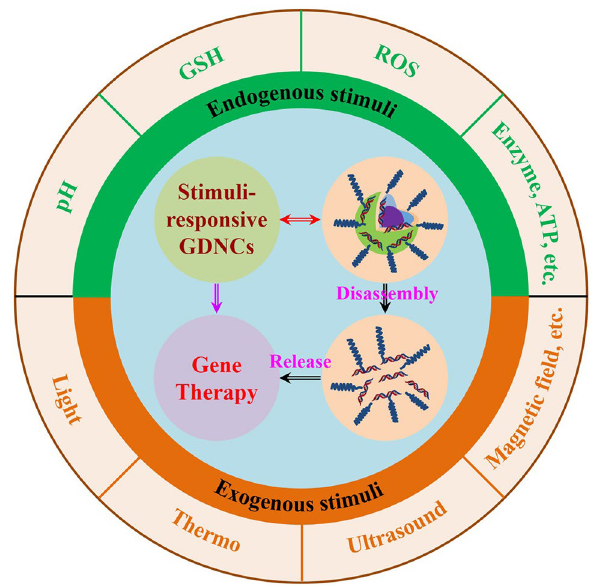
Fig. 1 Schematic diagram of stimuli-responsive nanocarriers for gene delivery and cancer